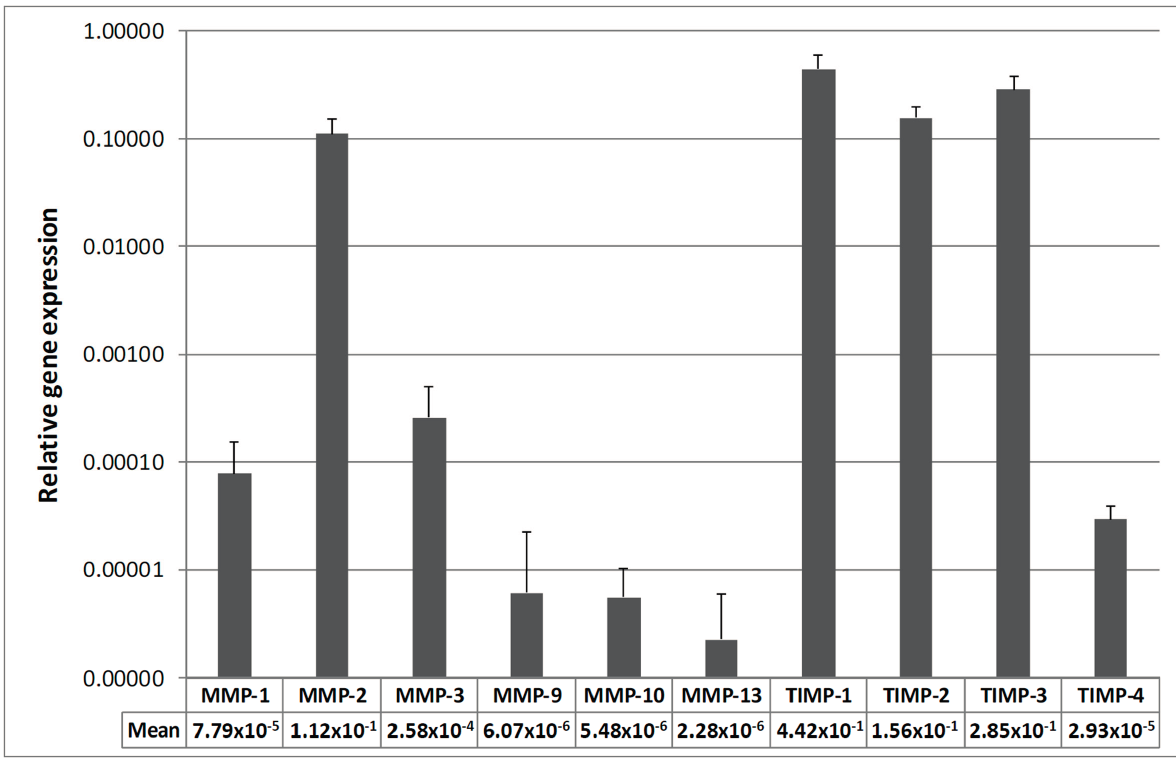
Figure 1. MMP and TIMP mRNA expression of all samples. Quantitative Real-Time PCR (qRT-PCR) analysis from torn RC tendons. The data represent the relative gene expression with 18S as reference gene using the Δ C t method with efficiency correction. Data are expressed as the mean ± SD ( n = 30) given in logarithmic form. MMP-2, TIMP-1, -2, and -3 showed the highest expression levels, while MMP-9, -10, and -13 showed lowest